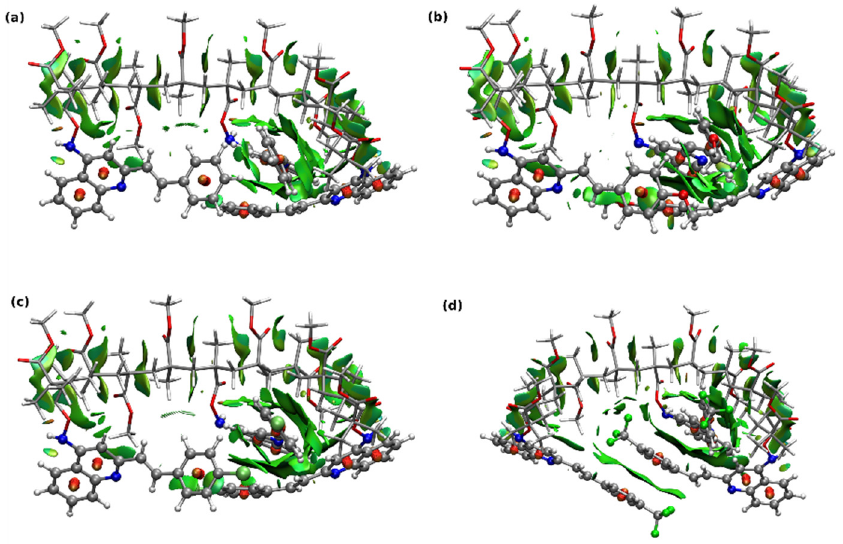
Figure 9. Optimized exemplary copolymer model structures with the non-covalent intramolecular interactions generated in NCIPlot depicted as the green surfaces. For better visibility, the copolymer chain is drawn with the licorice representations and styrylquinoline units—in CPK. ( a ) COP0, ( b ) COP1, ( c ) COP2, ( d ) COP3.